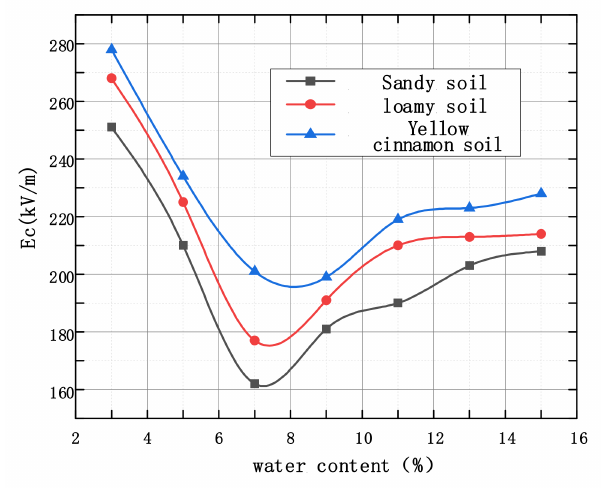
Figure 5. The influence of water content on the critical field strength of soil